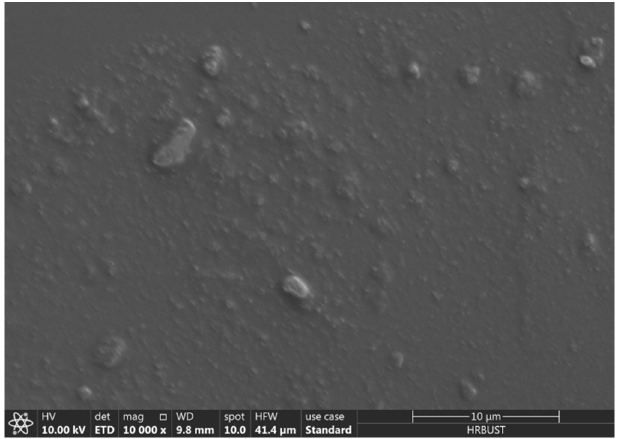
Figure 8. Sectional SEM image of 5 wt% CCTO/ silicone rubber (PDMS).